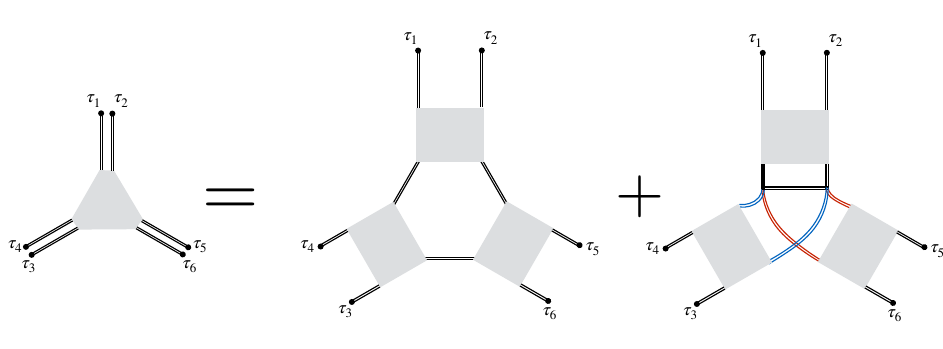
. We note that there V (3)